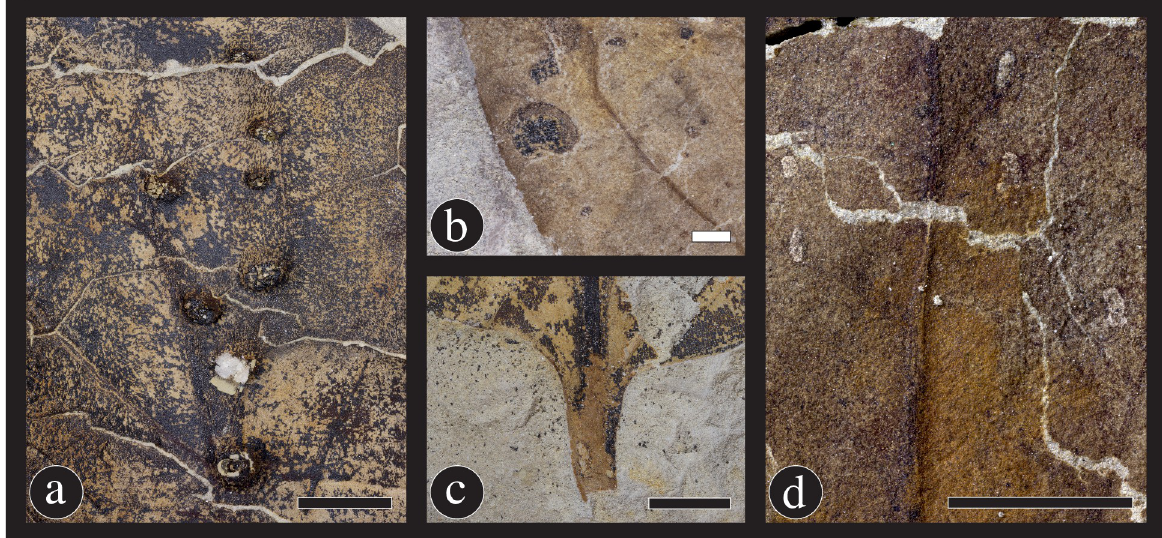
Fig 13. Galling and oviposition damage on Catula gettyi . (A) DT33 & DT34; Galls located on primary veins and secondary veins, respectively (DMNH 41577). (B) DT32; Galls located on the laminar surface, but avoiding primary and secondary venation (DMNH 41573). (C) DT85; Galls located on the petioles of leaves or petiolules of leaves (DMNH 41592). (D) DT101; Oviposition consists of multiple, scattered ovate-shaped scars produced by an insect bearing a robust ovipositor (DMNH 41570). Black scale bars = 5 mm; white scale bars = 1